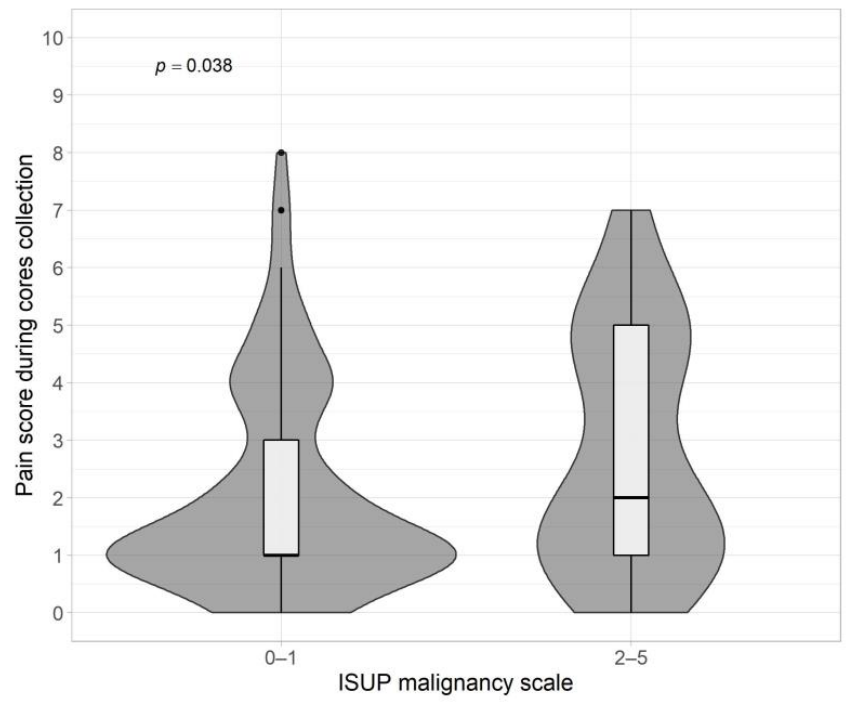
Figure 4. Pain score vs. ISUP malignancy scale.